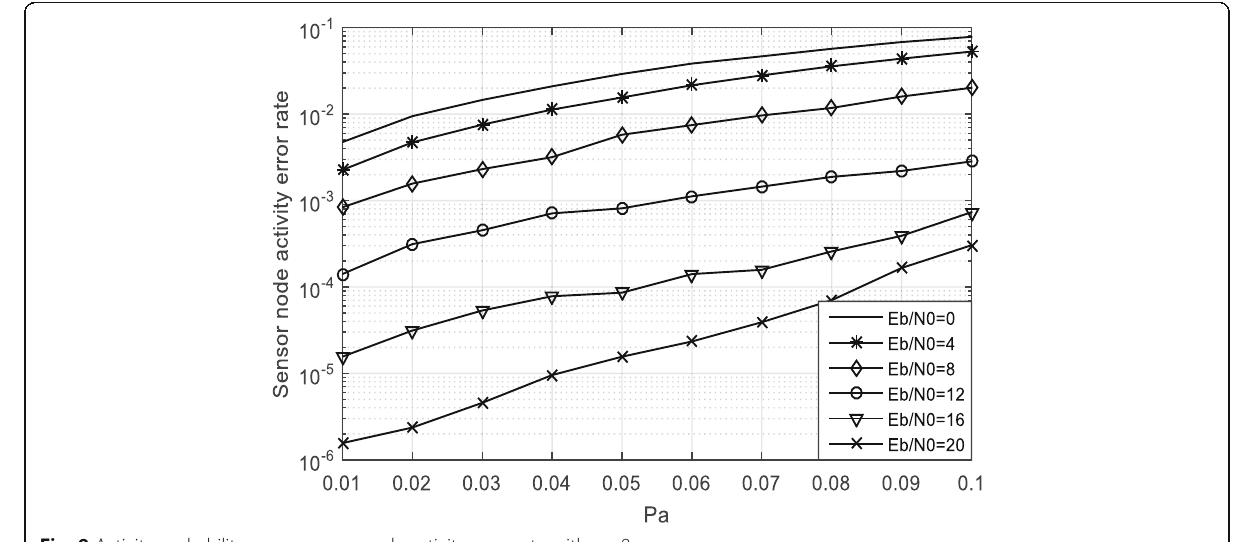
Fig. 9 Activity probability versus sensor node activity error rate with v = 8